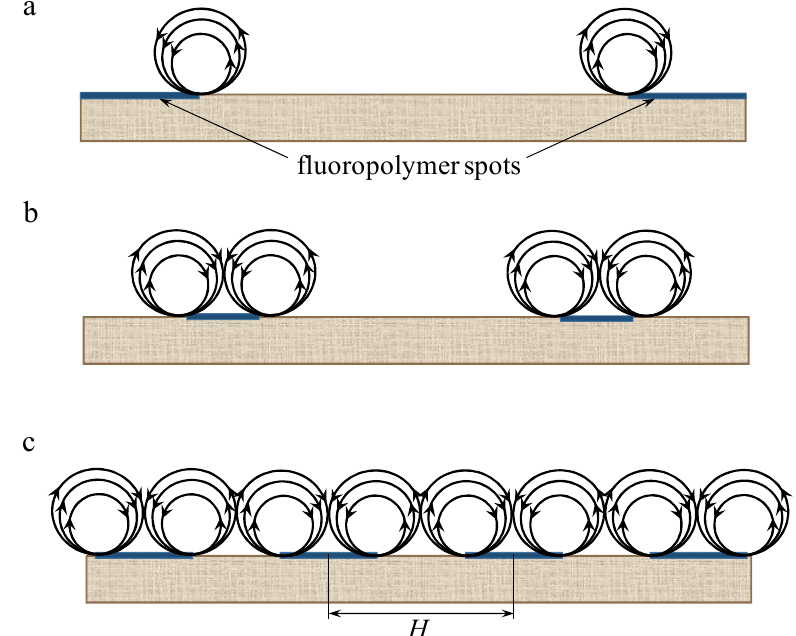
Figure 13. Scheme of the distribution of electroconvective vortices at the surface of AMX-Sb 2 ( a ), AMX-Sb 1 ( b ), and AMX-Sb 5 ( c ). H is the minimum distance between the repeating elements of the surface heterogeneity.